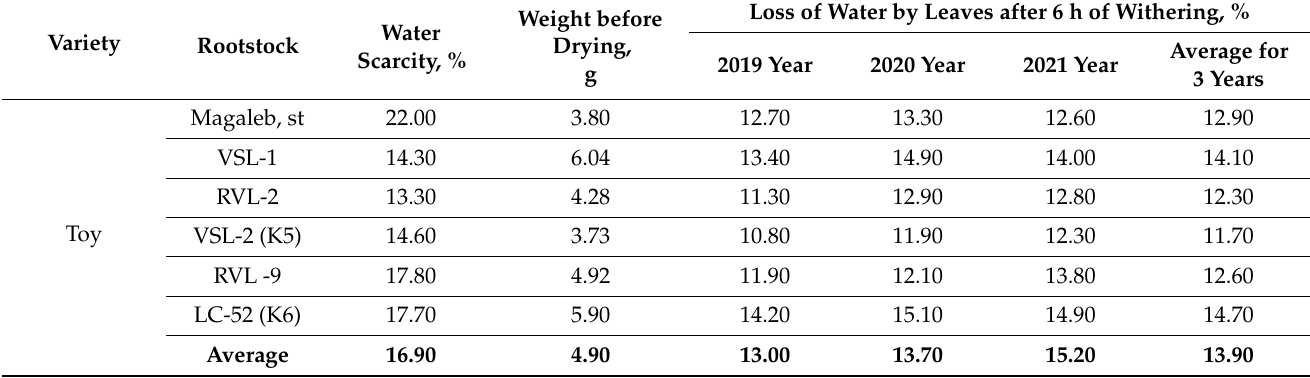
Table 2. Water-holding capacity of cherry leaves on various rootstocks at critical summer